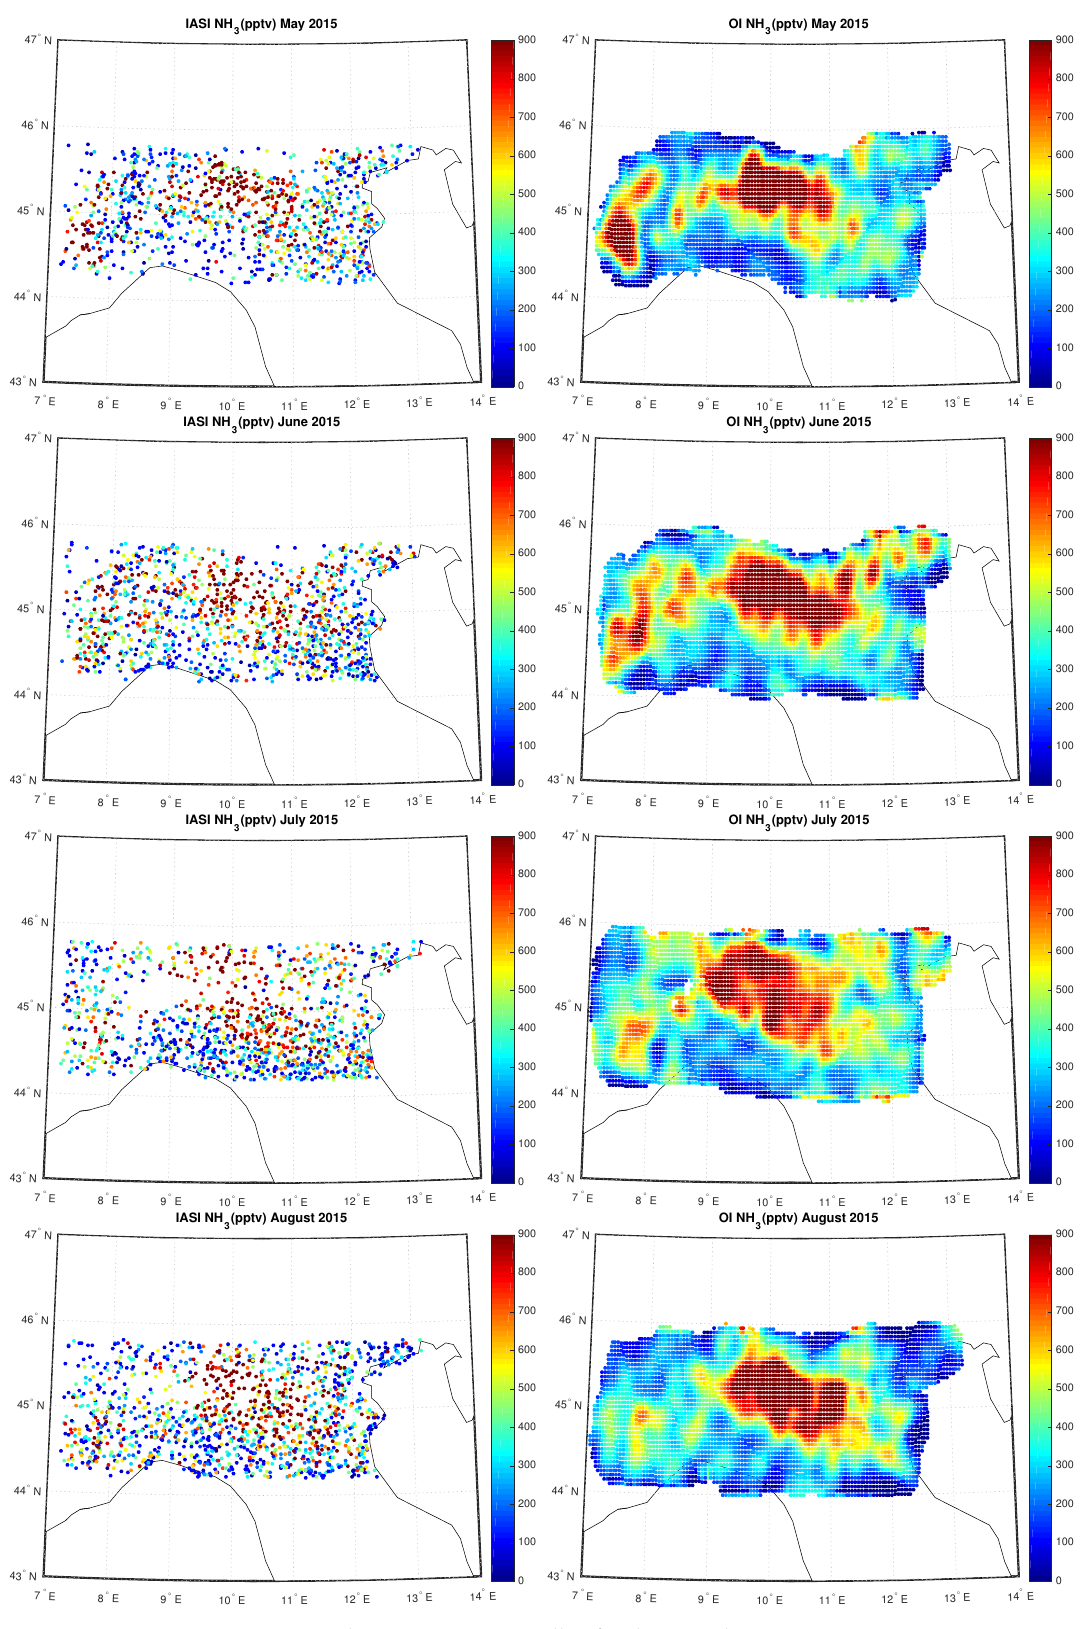
Figure 12. IASI and OI NH 3 over Po-Valley for the period May–August